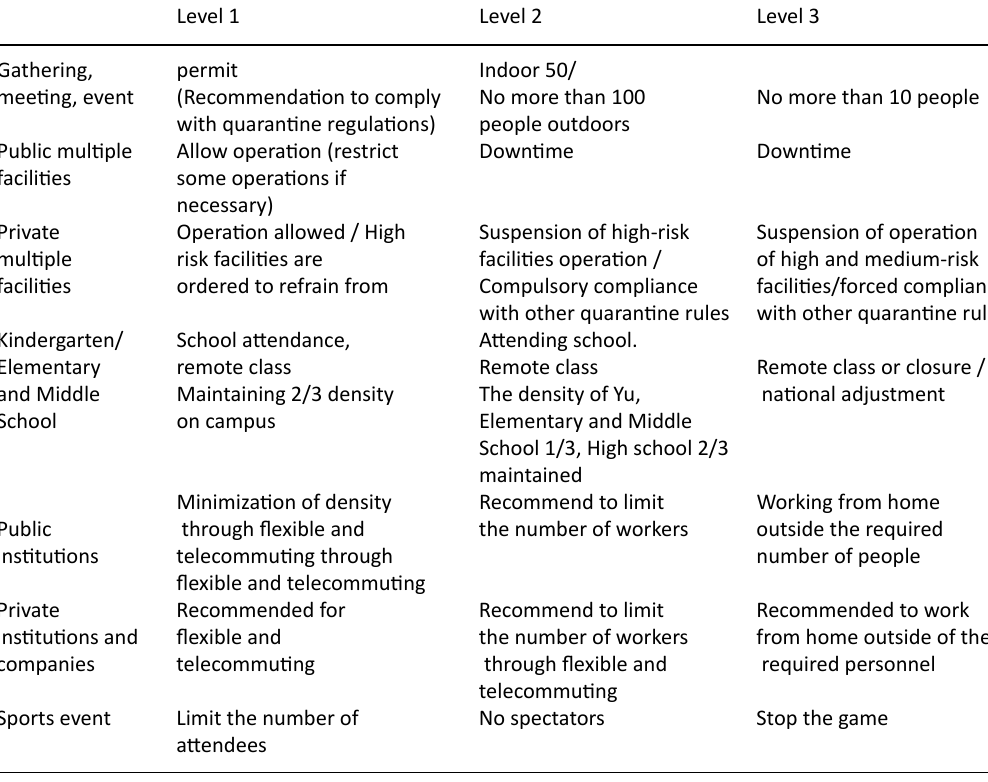
table 1. Step-by-step measures for social